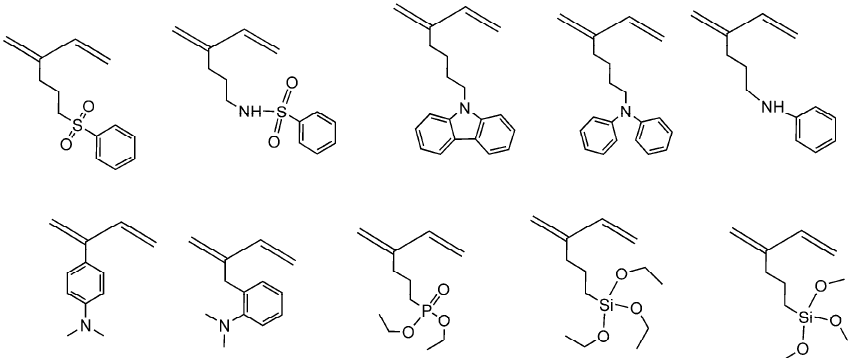
Figure 15. Reported 2-substituted 1,3-butadienes [152,153].